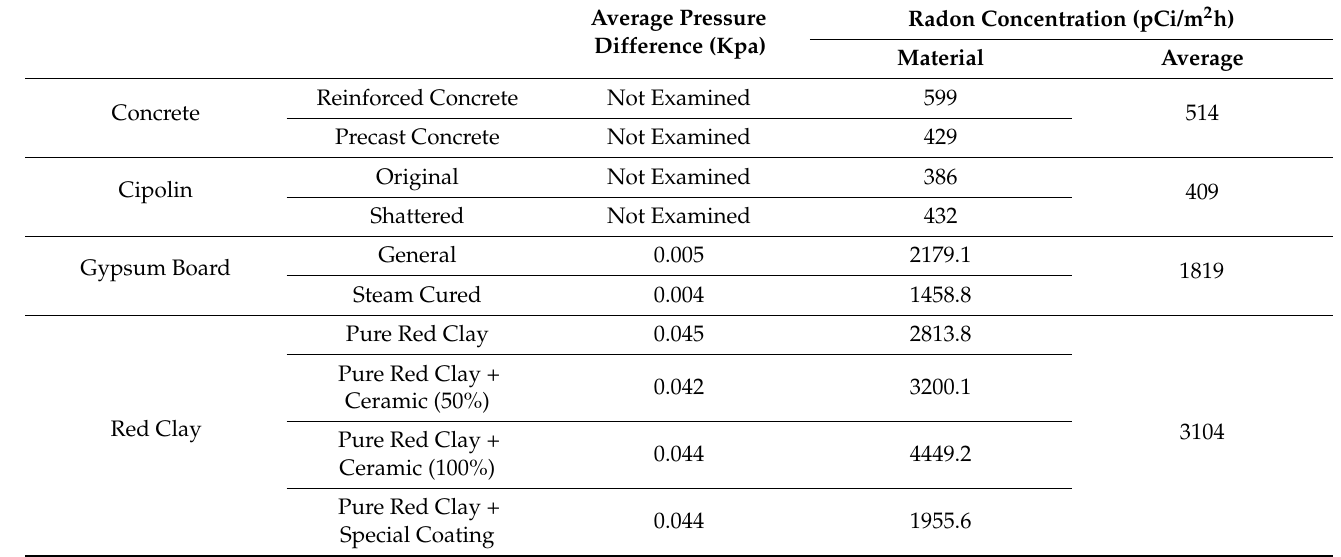
Table 3. Laboratory measurement result of radon gas emission by material.